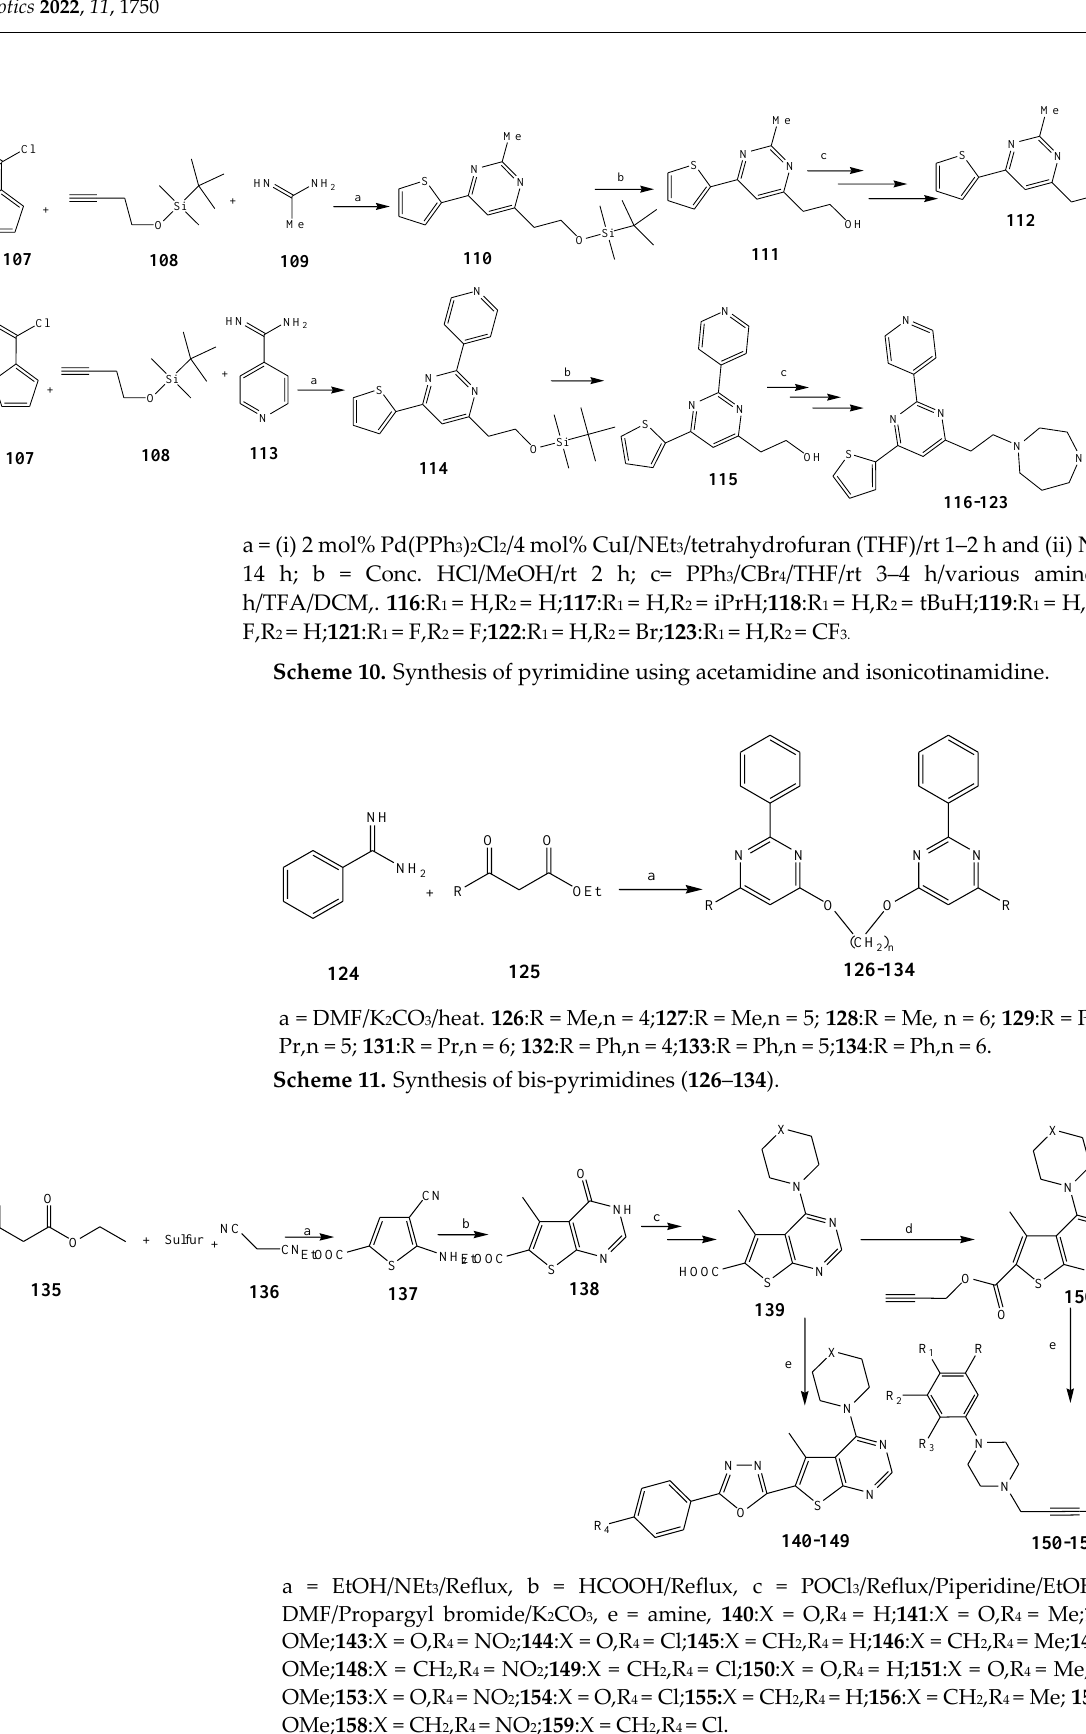
= 3-NO 2 Ph,R = Benzyl; 104 :Ar = 3-NO 2 Ph,R = Ph, 105 :Ar = 4-OHPh,R = Ph, 106 :Ar = 2-Cl-C 6 H 4 ,R = Ph.